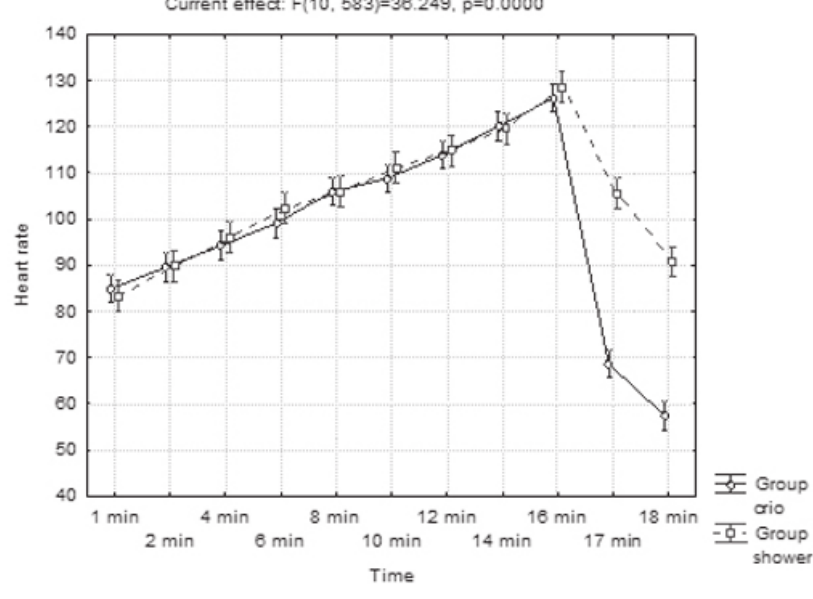
FIGURE 1. Changes in HR values at 1-minute and 2-minute intervals in CRIO and SHOWER groups